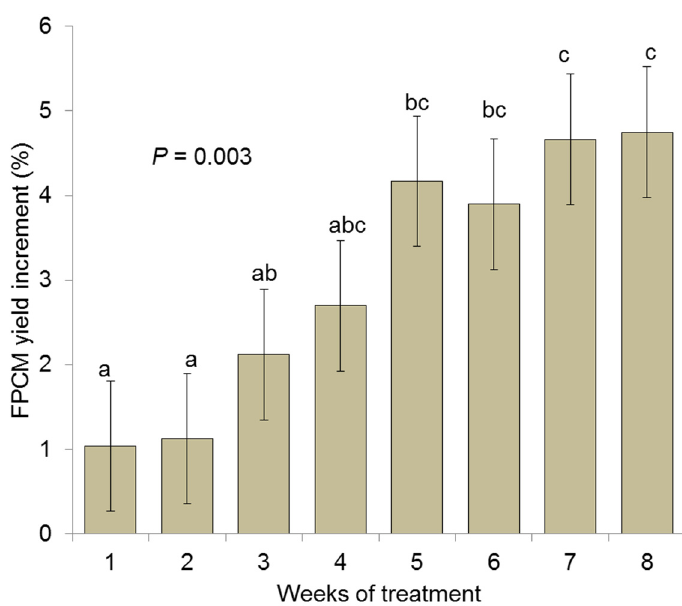
Figure 3. E ff ect of supplementing an essential oil blend (1 g / d per cow) to lactating dairy cows on the Figure 3. Effect of supplementing an essential oil blend (1 g/d per cow) to lactating dairy cows on the weekly fat and protein corrected milk yield (FPCM) based on 15 studies. The e ff ect was expressed as a weekly fat and protein corrected milk yield (FPCM) based on 15 studies. The effect was expressed as percentage of change respect to non-supplemented a percentage of change respect to non-supplemented cows.